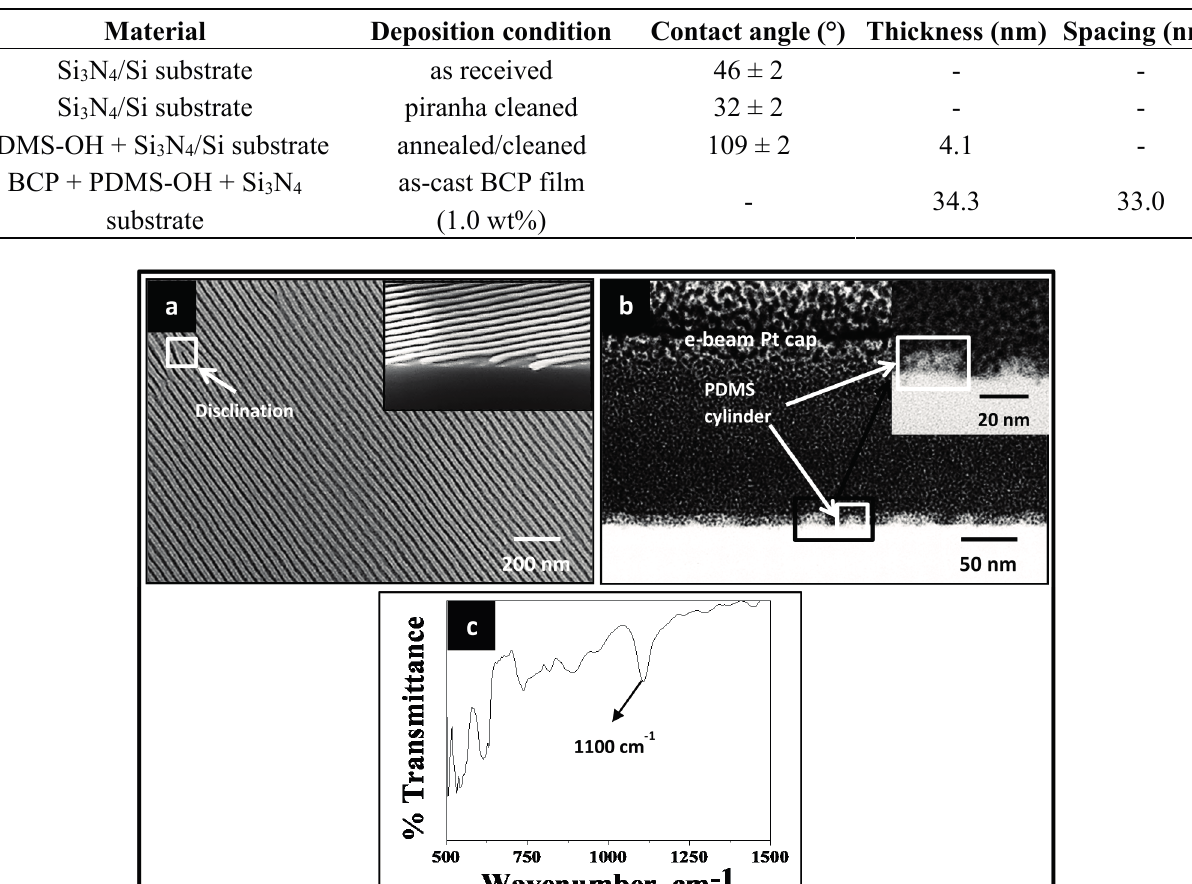
Table 2. Measured water contact angle and film thickness (ellipsometery) of various films at planar substrates. The table also gives the BCP domain size (pitch) as measured by SEM.